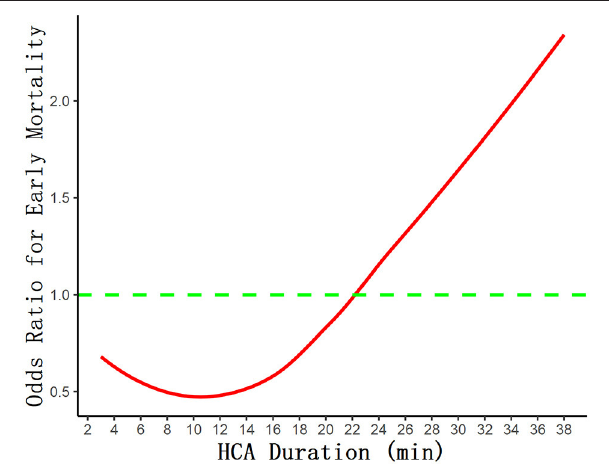
FIGURE 2 | The association between the HCA time and surgical mortality was evaluated with restricted cubic spline curve based on Cox proportional hazards